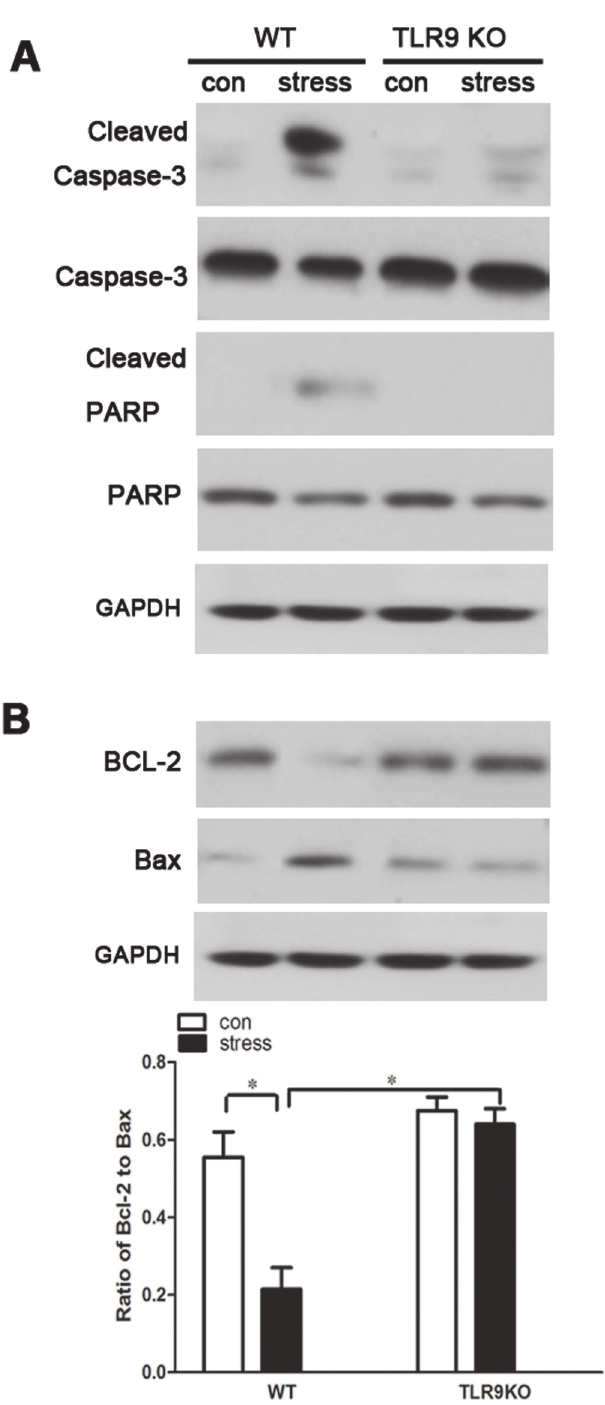
Fig 5. TLR9 deficency inhibits stress-induced change in caspase-3 and PARP activation and ratio of Bcl-2/Bax TLR9 knockout mice or wild type BALB/c mice aged 6 to 8 weeks were subjected to a 12 h physical restraint daily. After 2 d stress, mice were sacrificed by cervical dislocation, and the macrophages were harvested, purified and cultured (5 × 10 5 cells/well) on culture plates for 24 hours. The expression of cleaved caspase-3 and cleaved PARP (A), and Bcl-2/Bax (B) was analyzed by Western blot. Means and SEs were calculated from 7 mice per group. * p < 0 . 05 , ** p < 0 . 01 compared with indicated groups.